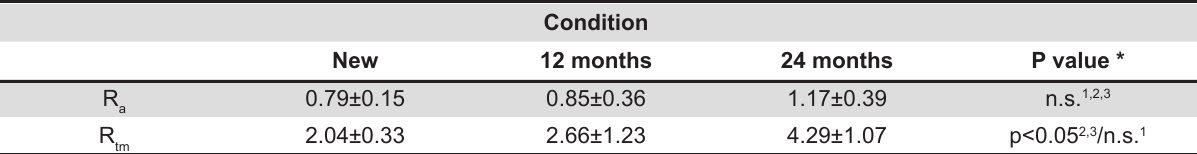
Table 2- Mean and standard deviation of surface roughness (R (R ) found on the brackets’ tm